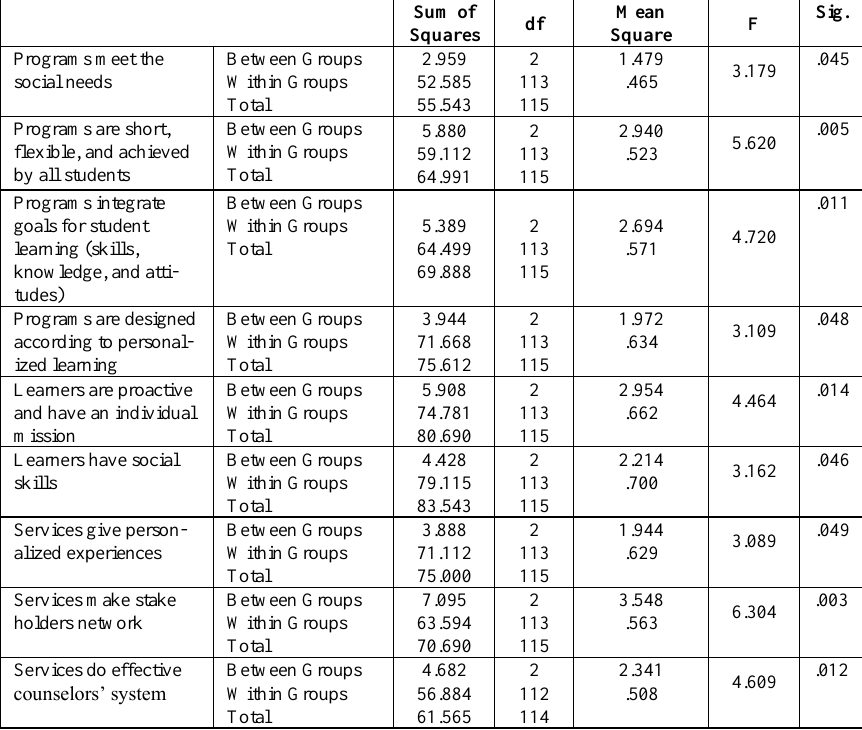
Table 8. ANOVA - Analysis of one-way variance in readiness for digital conversion at HUST among 3 groups of academic staff (Ph.D., Master, and Bachelor/Engineer)